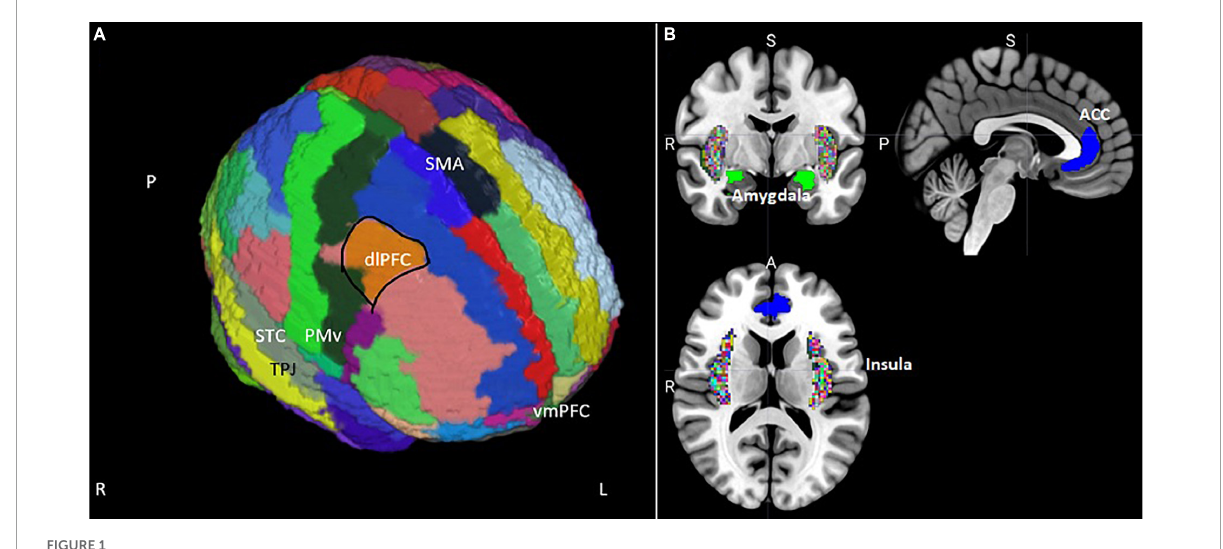
FIGURE1 (A) Position of the supplementary motor area (SMA), dorsolateral prefrontal cortex (dlPFC), ventral premotor cortex (PMv), superior temporal cortex (STC), and ventromedial prefrontal cortex (vmPFC) on an MNI template brain segmented using the AAL atlas (Tzourio-Mazoyer et al., 2002). Masks for the dlPFC and vmPFC were extracted from the Mindboggle segmentation (Klein et al., 2005). (B) Coronal, sagittal, and transversal views of subcortical regions relevant to misophonia extracted from Mindboggle and from the FSL Harvard-Oxford sub-cortical structural segmentations. The anterior cingulate cortex (ACC) is blue, the amygdala is green, and the insular cortex is colored